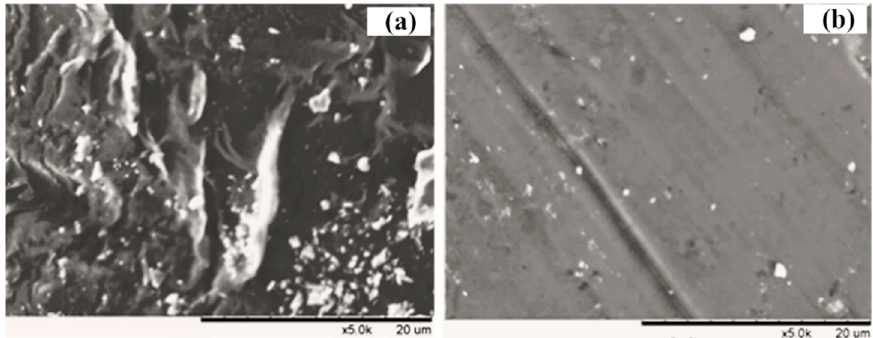
Figure 8. SEM images of fouled membrane in the CMBR ( a ) and in the IPMBR ( b